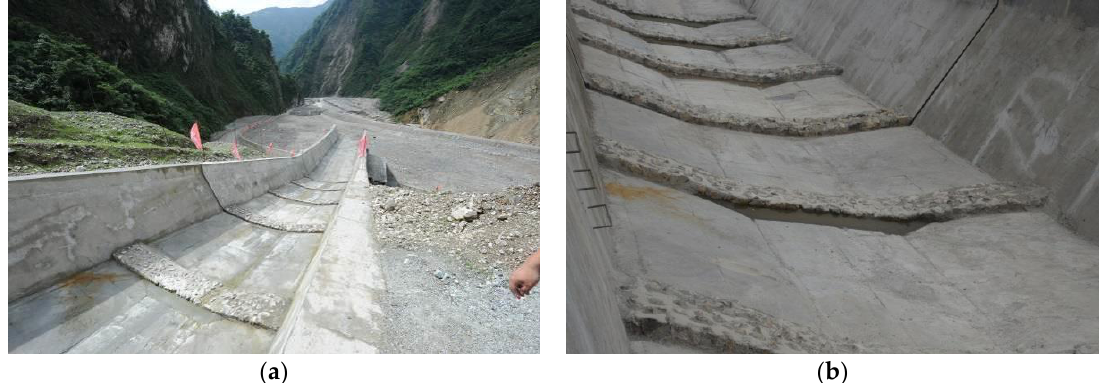
Figure 8. Pictures of roughening belts for channel bottom turbulence completed. ( a ): From an upstream perspective of roughening belts, ( b ) Structural details of roughening belts.